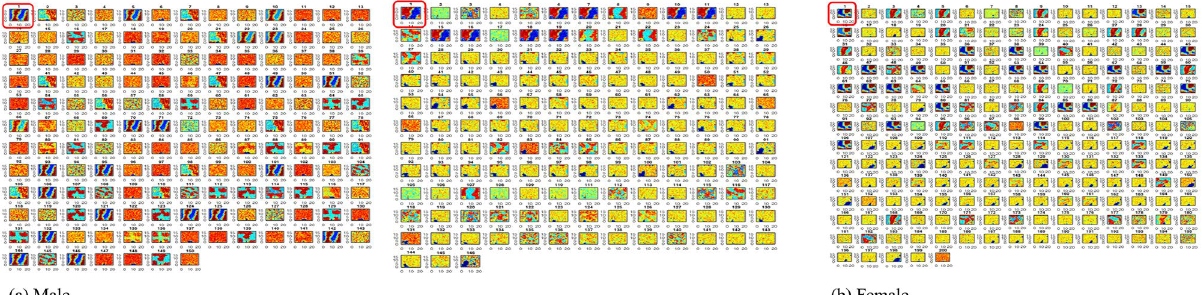
Figure 7. SOM component planes visualization for North American isolates. Component planes 1 (encircled) represent the SARS-CoV-2 reference genome. The male isolates have 2 SOM maps while the female isolates have 1 map, each with country and (component plane map position(s)) distributed as follows: Male—( a ) Map 1: Mexico (2–46), USA (47–150). Map 2: USA (2–23), Panama (25–102), Saint Martin (103–105), Guadeloupe (106–109), Canada (110–112), Costa Rica (113–145), Dominican Republic (146). Female—( b ) Map 1: Mexico (2–34), USA (35–106), Panama (107–165), Saint Martin (166–168), Guadeloupe (169–176), Canada (177–182), Costa Rica (183–196), Dominican Republic guage. The extracted clusters are necessary for supervised labeling of the classification targets. By disassembling the SOM correlation hunting matrix space, we attribute these associations to disparate classes of discovered viral sub-strains. The outcome are cognitive maps with 7 clusters simulating the discovered SOM patterns and coun- tries/isolates linked to these patterns for male and female patients (Supplementary Table S3). Each sub-strain cluster holds similar isolates that belong to a related pattern bounded by certain degree of association or cor- relation range, established by the SOM, and captures all isolates discovered within this range. We also captured from the SOM component planes any progression in patterns showing sub-strain(s) development leading to well separated cluster image(s). The cognitive knowledge would assist early contact tracing of cases in emerging disease situations as well as establish how the reference genome has evolved over time. This additional knowl- edge also permits further characterization of the viral sub-strains, as our results allow unique SARS-CoV-2 base pairs sequence identification (which do not appear in other viral sub-strains) and could be useful as baselines for designing new primers that permit further insights and examination by experts. ANN performance evaluation. From the cluster patterns established by SOM, the datasets were labeled for further processing (see Male_SOM and Female_SOM worksheets of SupplData8.xlsx). To create a common scale and ensure that all input features have equal treatment in the model, the datasets were normalized using the minmax normalization technique [Eq. (1)]. The minimum and maximum components are obtained from the means of the nucleotide transitions or mutations features.